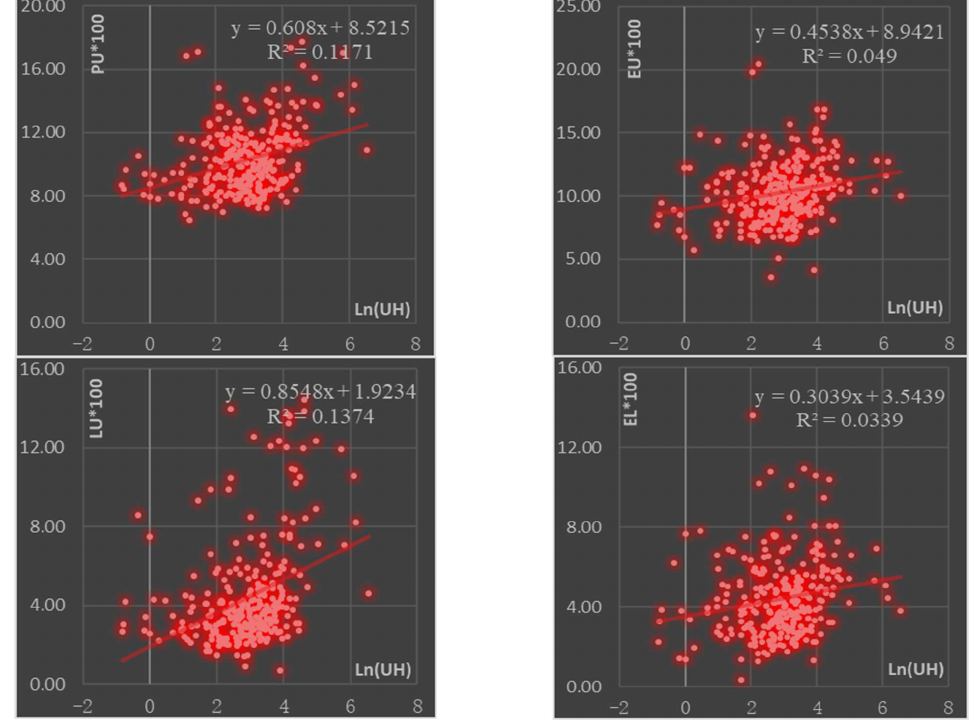
Figure 5. Scatterplot of urban household carbon emissions and urbanization indicators in